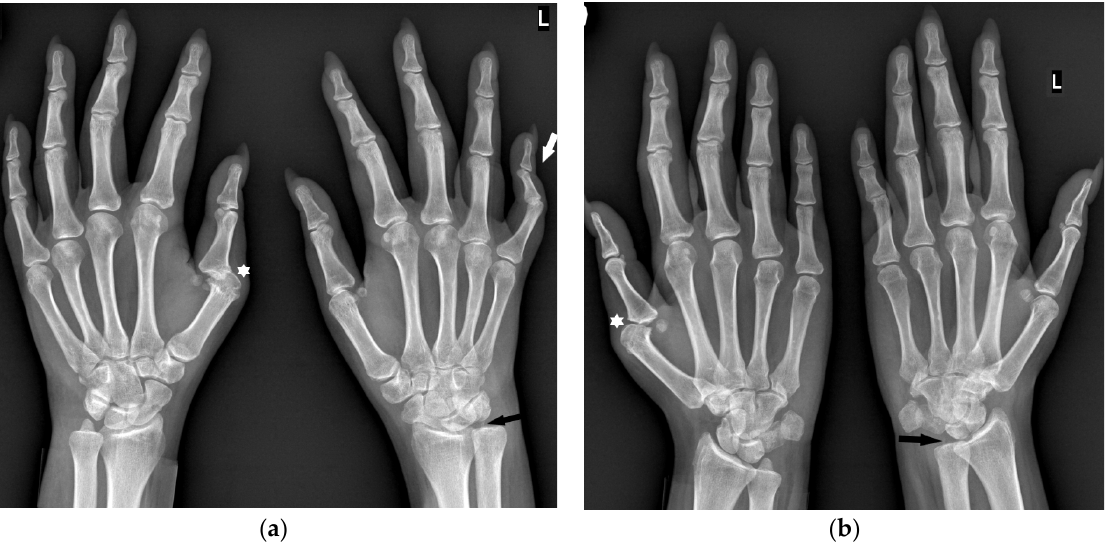
Figure 3. A 30-year-old female with seronegative RA. PA ( a ) and Nørgaard radiographs ( b ) of bilateral hands. Note the boutonnière deformities, most prominent in the left small finger (white arrow). There is left RCJ space narrowing with scattered bone cysts and chronic deformity of the scaphoid bone. Note the osteolysis of the left ulnar styloid process (black arrow). Scattered bone cysts are observed in the right carpal bones. Note the erosive changes and bone cysts in the right first MC head with subluxation of the MCP joint (star).